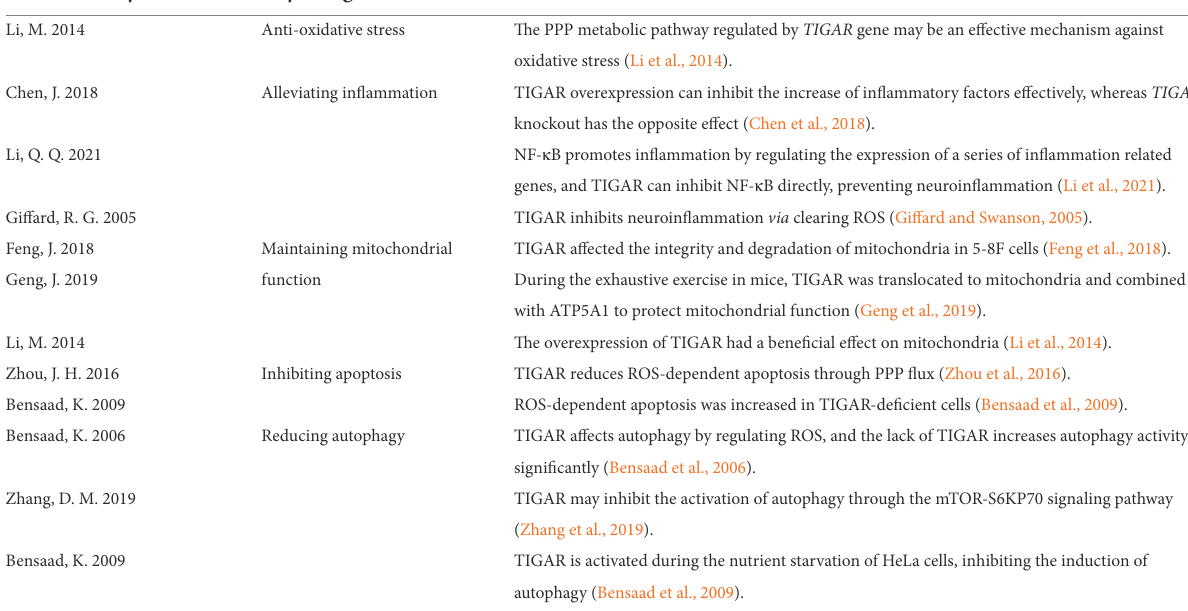
TABLE 2 The physiological function of